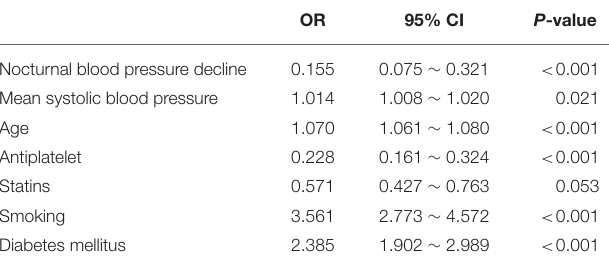
TABLE 4 | The multivariate logistic regression analysis between EPVS and control. OR